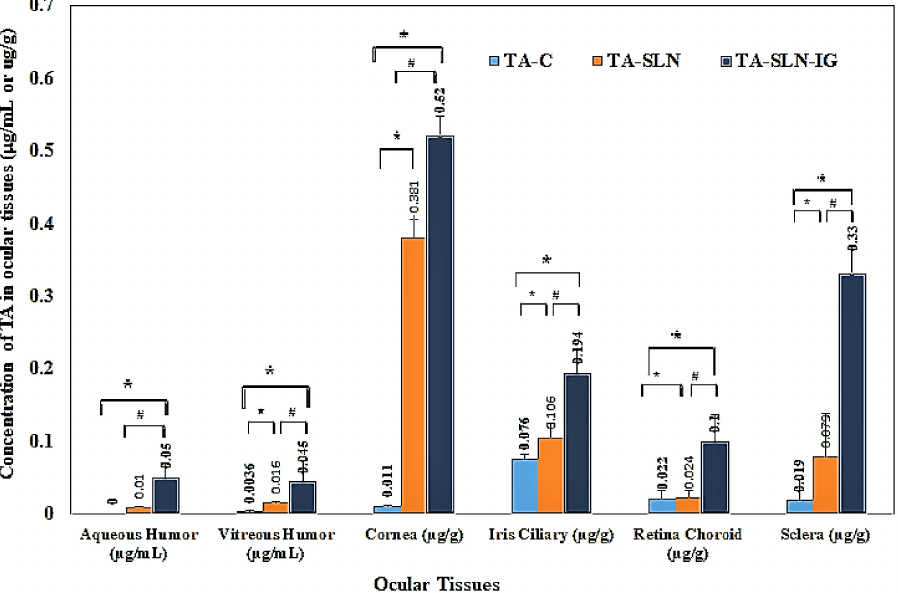
Figure 6. Concentration of TA in ocular tissues from TA-SLN (F5), TA-SLN-IG (F13), and TA-C at 6 h post dosing after topical administration in New Zealand albino rabbits (mean ± SD, n =